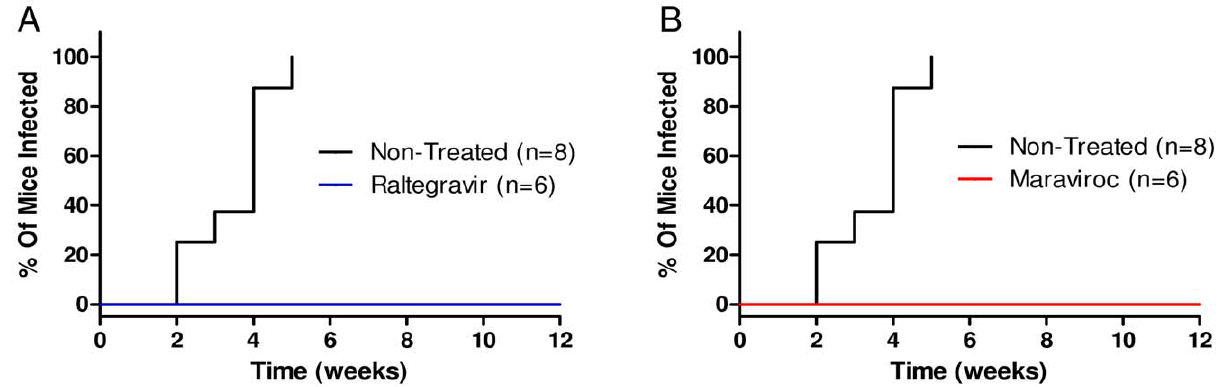
Figure 1. Oral administration of raltegravir or maraviroc protects humanized mice against vaginal HIV-1 challenge. RAG-hu mice were challenged by vaginal route after oral administration of raltegravir or maraviroc as described in Methods. Blood was collected weekly from infected mice and the status of HIV-1 infection was determined by Q-RT-PCR. The viral challenge experiments were performed at same time for both of the drugs and the same set of control non-treated infected mice were used for comparison. Kaplan-Meier plots of time course of appearance of viremia in drug treated versus non-treated virus challenged mice. A. Raltegravir treated B. Maraviroc treated. doi:10.1371/journal.pone.0015257.g001 PLoS ONE |